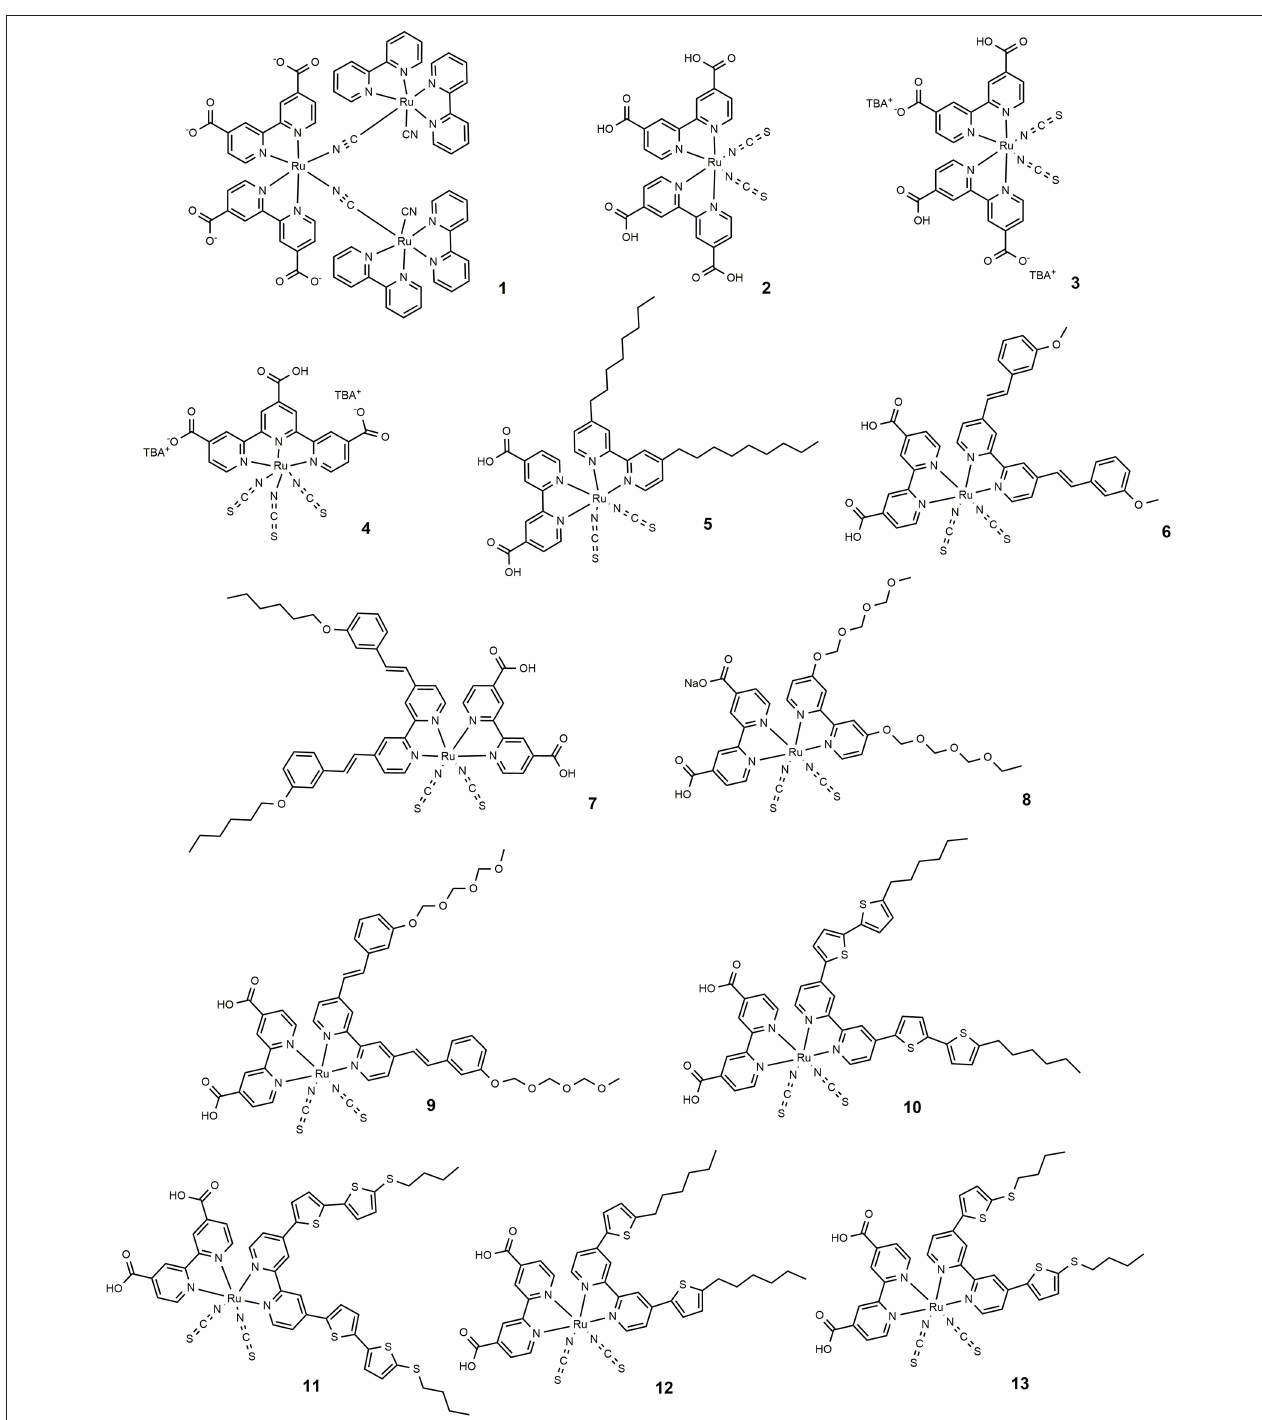
FIGURE 2 | Chemical structure of dyes 1–13.